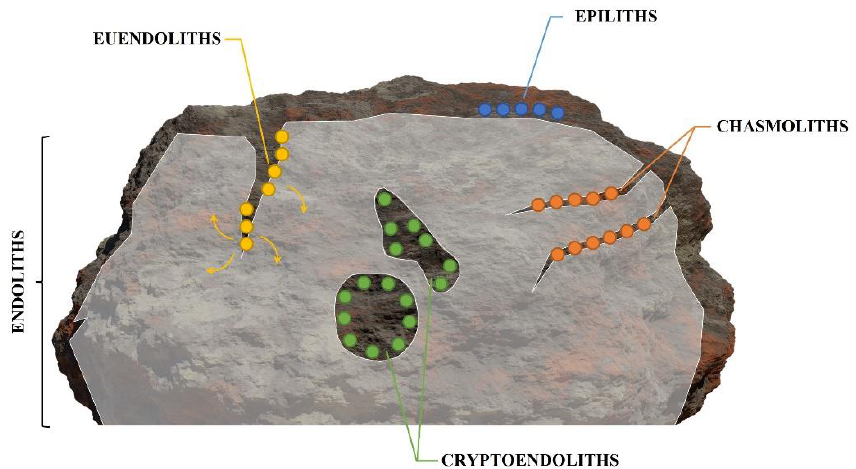
Figure 1. Types of endolithic organisms in relation to a hard rocky substrate (modified from [40]).